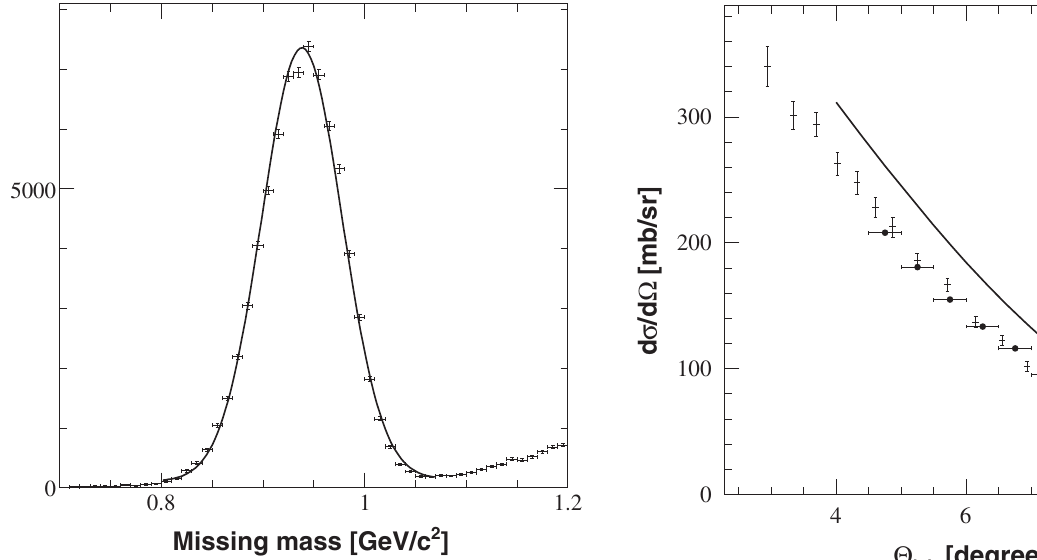
FIG. 9. Spectrum of missing masses measured for the pp ! pX reaction at 2.65 GeV showing a proton peak compared to a Gaussian fit. This peak can be cleanly separated from the contributions from pion production which start at 1 : 07 GeV =c 2